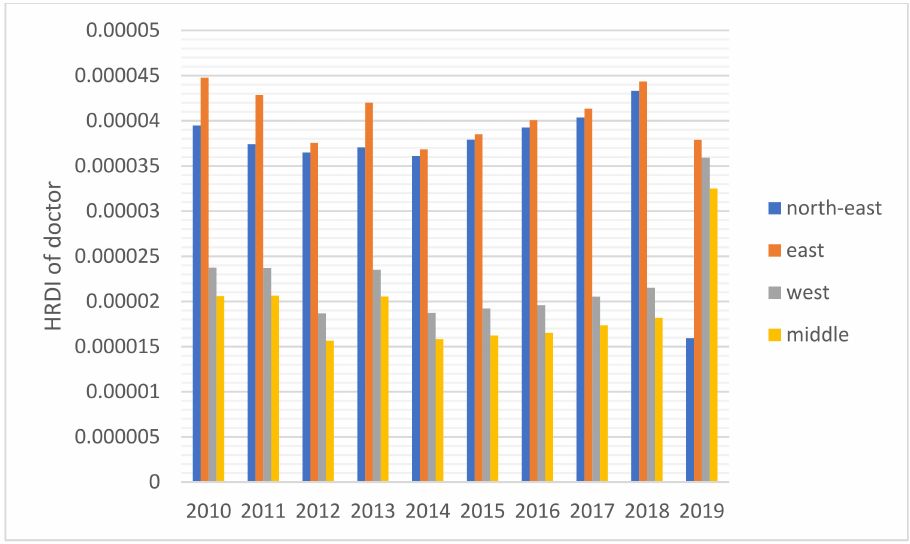
Figure 4. The HRDI of the health resources in doctors when dividing China into four